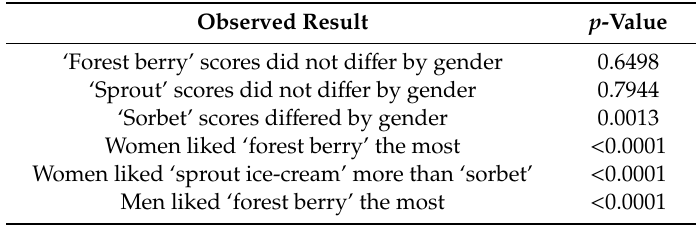
Table 6. Statistical analysis of consumer acceptance evaluation results of frozen desserts with sprouts (sprouts ice-cream and sorbet) and a reference product (forest berry ice-cream). Observed Result